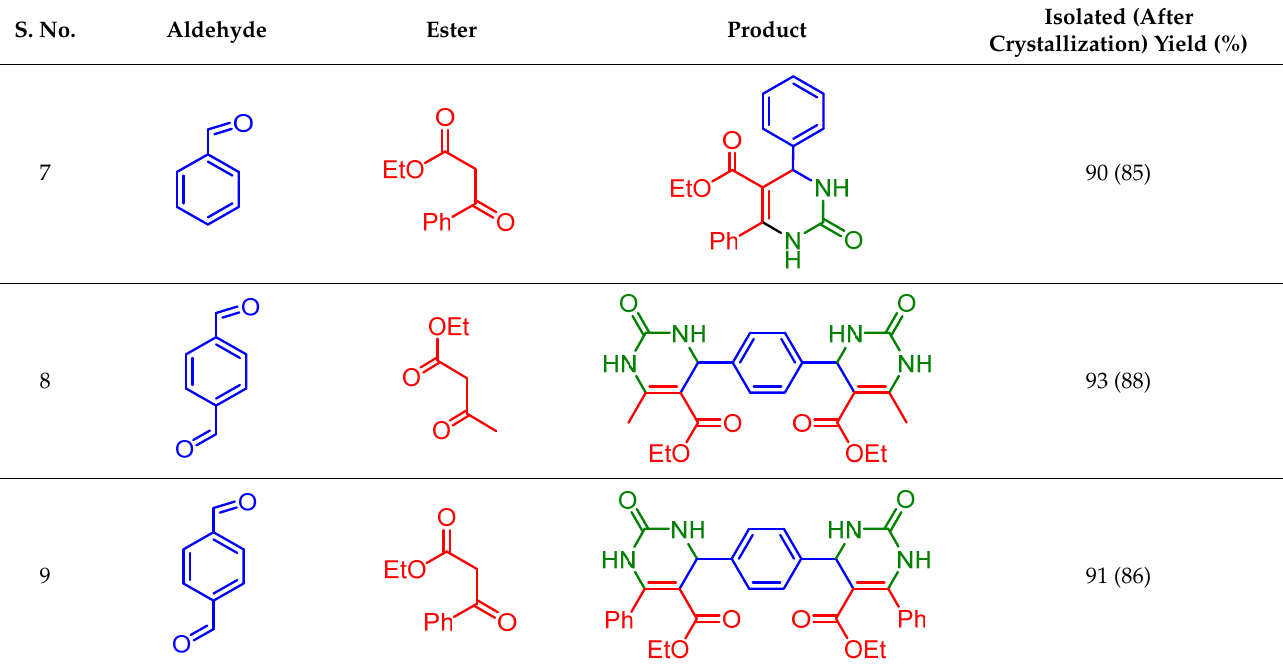
Table 4. Details for multicomponent Biginelli reaction for the synthesis of dihydropyrimidine-2- thione (reaction conditions: respective aldehyde (5 mmol), ethyl acetoacetate (5 mmol), thiourea (6 mmol), and catalyst 2 (0.015 g)) under solvent-free conditions at 80 °C for 3 h of reaction time.